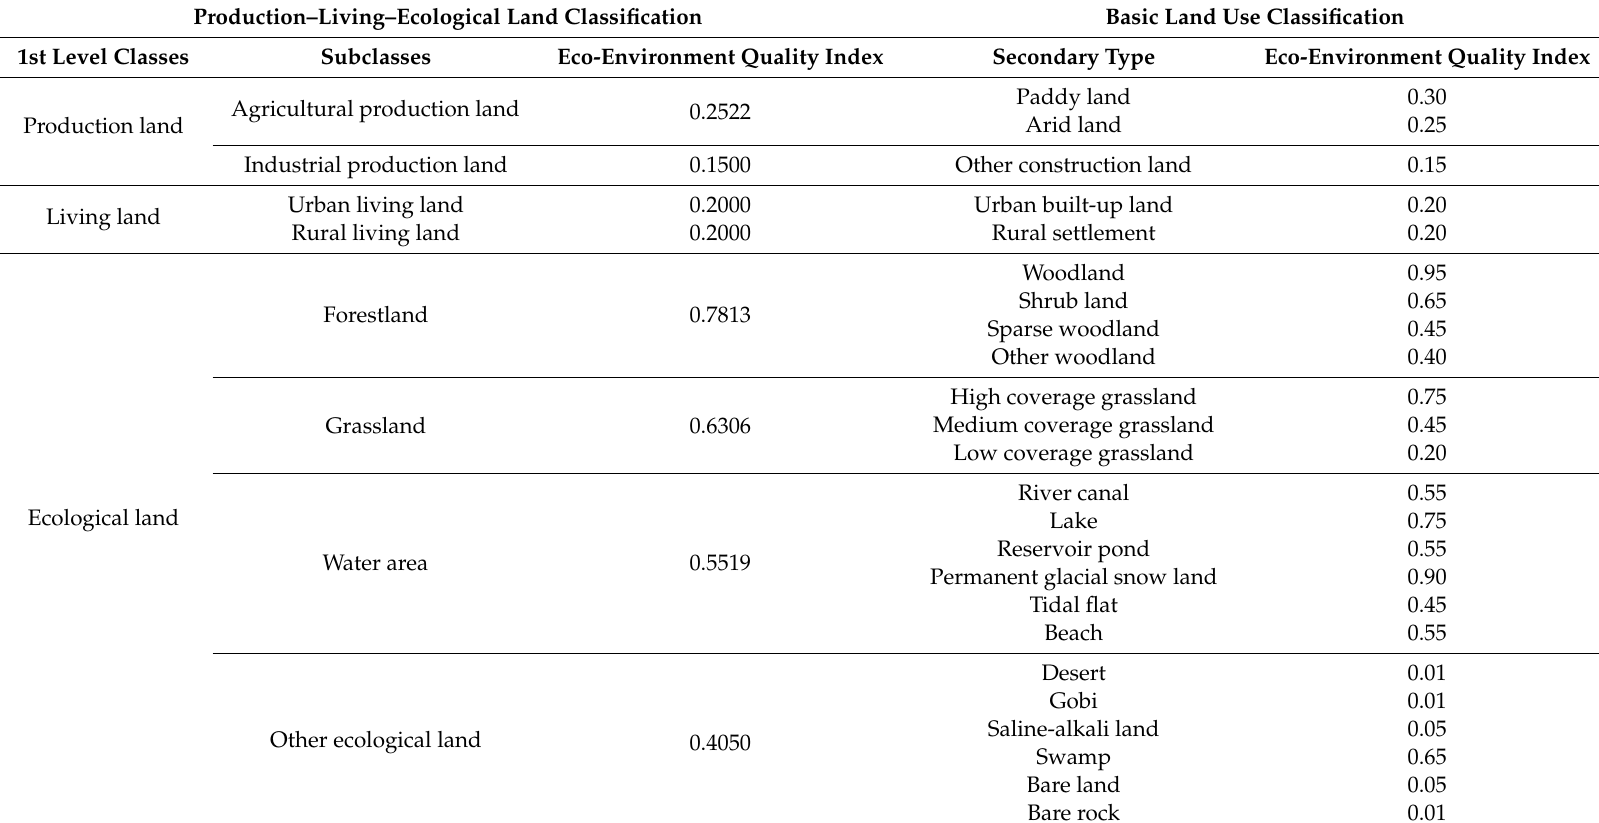
Table 1. Production–living–ecological land classification and eco-environmental quality